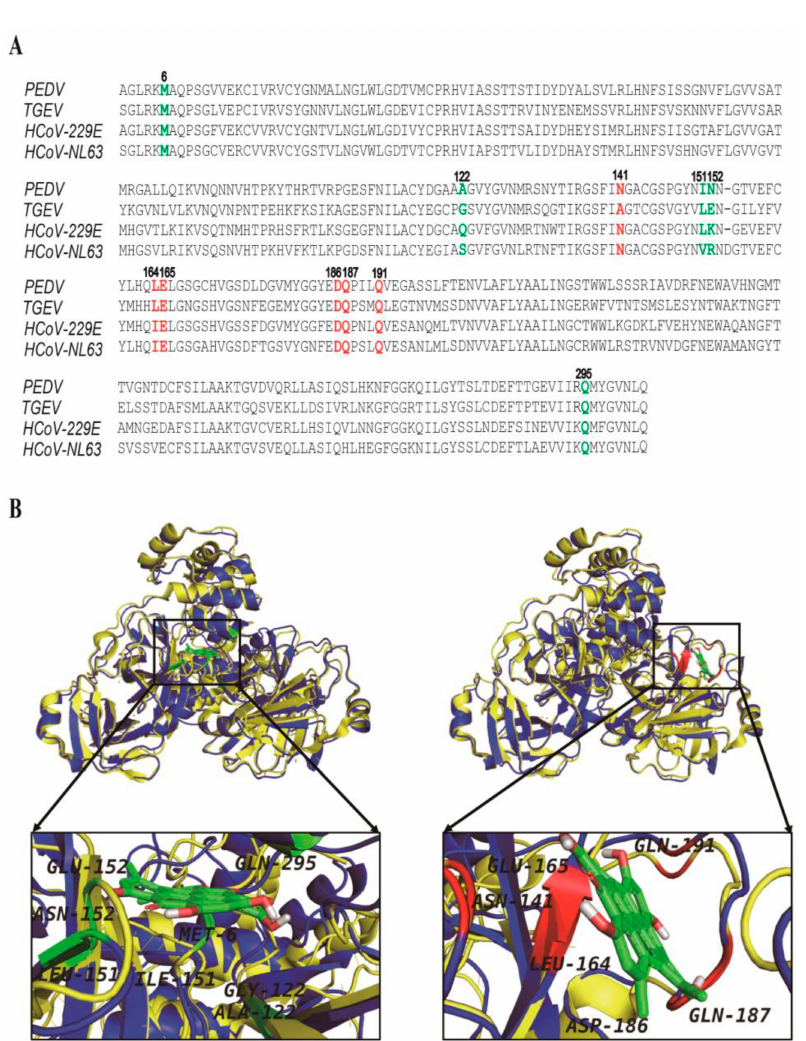
Figure 5. Hypericin targets the TGEV 3CLpro through the same region as PEDV. ( A ) The 3CL- pro sequences of the PEDV (Accession number: MN644470.1), HCoV-NL63 (Accession num- ber: ABE97129.1), HCoV-229E (Accession number: AGT21366.1), and TGEV (Accession number: P0C6Y5.1) are aligned by Clustal Omega tool (https://www.ebi.ac.uk/Tools/msa/clustalo, accessed on 29 April 2021). Solution 1 of hypericin targeting PEDV 3CLpro is shown in green, and solution 2 is in red. ( B ) The alignments of PEDV and TGEV 3CLpro 3D structures. The blue cartoon represents PEDV, and the yellow cartoon represents TGEV. Hypericin is shown as green ligand, and the residues mediating the binding of hypericin onto PEDV 3CLpro in solution 1 ( left ) and solution 2 ( right ) are